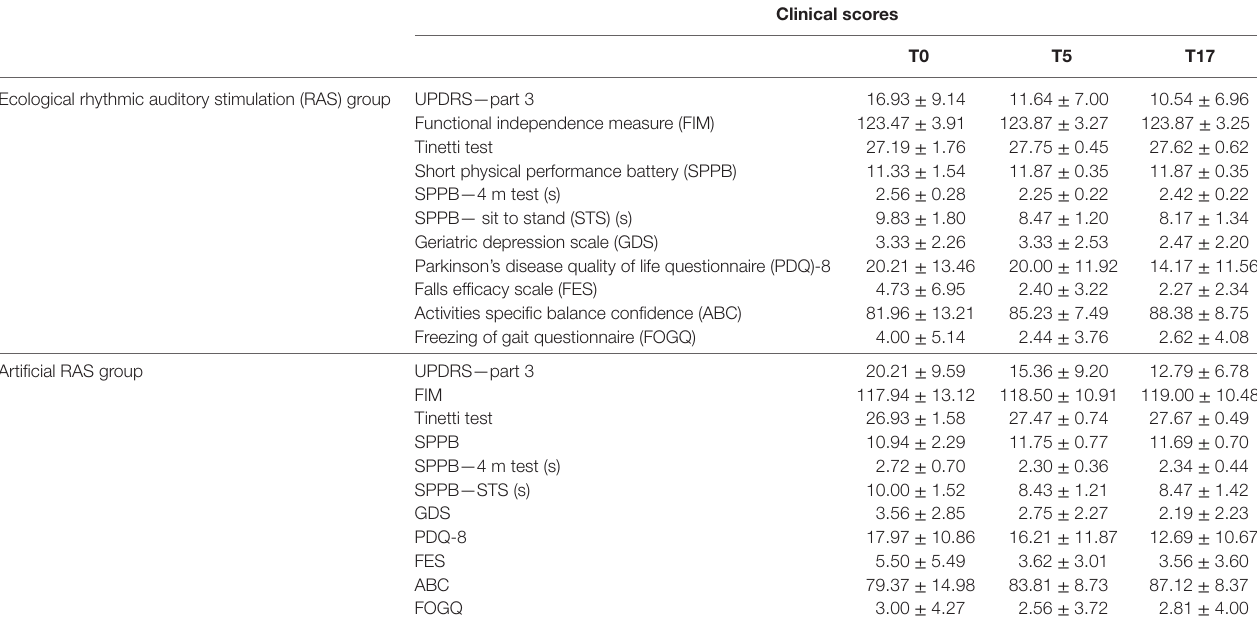
TaBlE 3 | Comparison between clinical scores assessed before and after rehabilitation for each group.